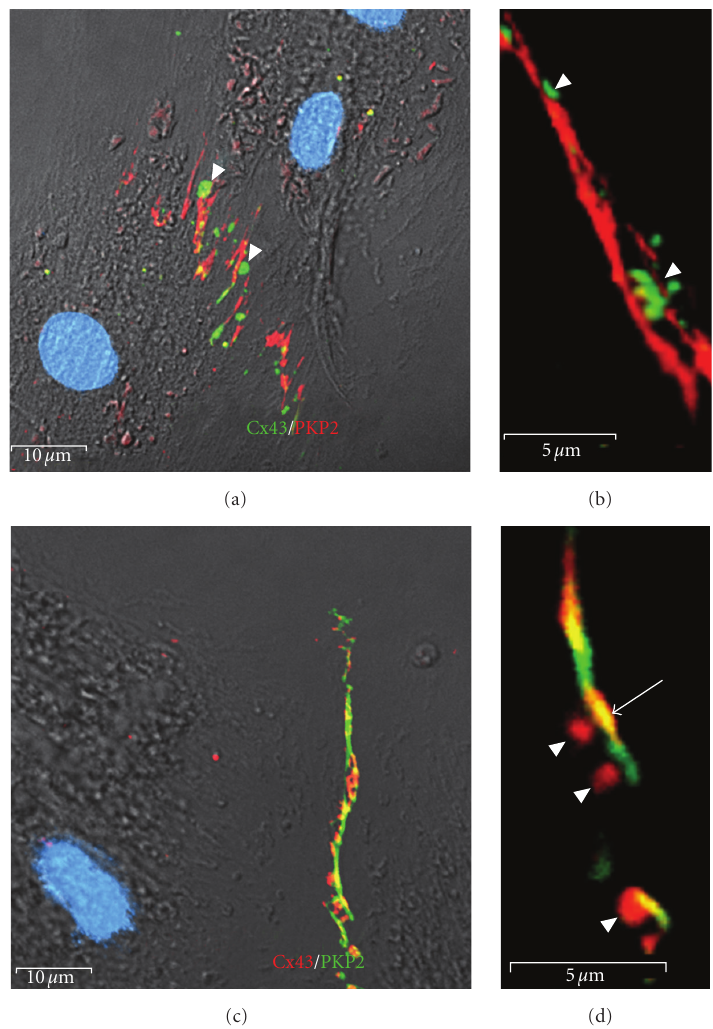
Figure 7: Connexin43 localization to cell-cell contact domains follows adhesion complex assembly. ARCs at 5 days post plating were immunolabeled for Cx43 (green: (a, b); red: (c, d)) and PKP2 (red: (a, b); green: (c, d)). Early in the assembly and organization of cell-cell contacts in ARCs in primary culture, adhesive sites do not contain appreciable amounts of Cx43 (green: (a, b); red: (c, d)). (a) Connexin43 localization to newly formed adhesive contacts as identified by PKP2 immunostaining. Note the subsarcolemmal accumulation of connexons at the apices of the interdigitized contacts (arrowheads). (b) High magnification image of newly formed contact with subsarcolemmal accumulation of connexons prior to insertion into the membrane. (c, d) Low and higher magnification images of subsarcolemmal accumulation of connexons (arrowheads) prior to their insertion into the membrane. Note the regions of overlap of PKP2 and Cx43 immunolabeling indicating areas of mature gap junctions within the adhesive domains (arrow). Also, note that the Cx43 inserts into the membrane preferentially at adhesive sites (a, d). Scale bars are 10 μ m (a, c) and 5 μ m (b,